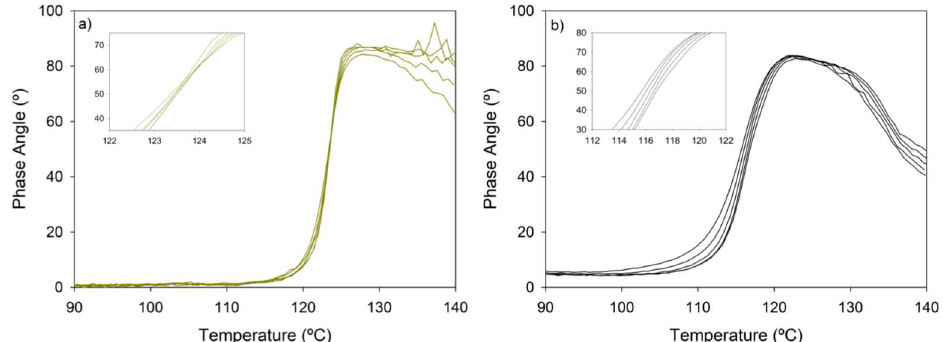
Figure 3. Dynamic rheology measurements at a heating ramp of 1 °C·min −1 to determine the degelation of ( a ) BMI689-F400 and ( b ) Humins-DA. Frequencies (Hz): 0.3; 0.6; 1; 1.8; 3.1 (one curve for each frequency). A Tgel value of 123 °C is found for BMI689-F400 whereas no clear T gel was found for Humins-DA despite the gel transition being shifted to lower temperatures.